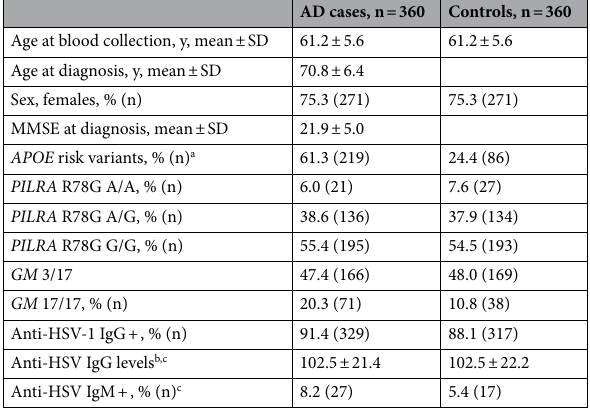
Table 1. Descriptive statistics in the discovery dataset, NSHDS. AD Alzheimer’s disease, y Years, SD Standard deviation, n Number, MMSE Mini-mental state examination, APOE Apolipoprotein E. a Genotype ε3/ε4 or ε4/ ε4. b Expressed in arbitrary units. c Among anti-HSV-1 IgG seropositive subjects.